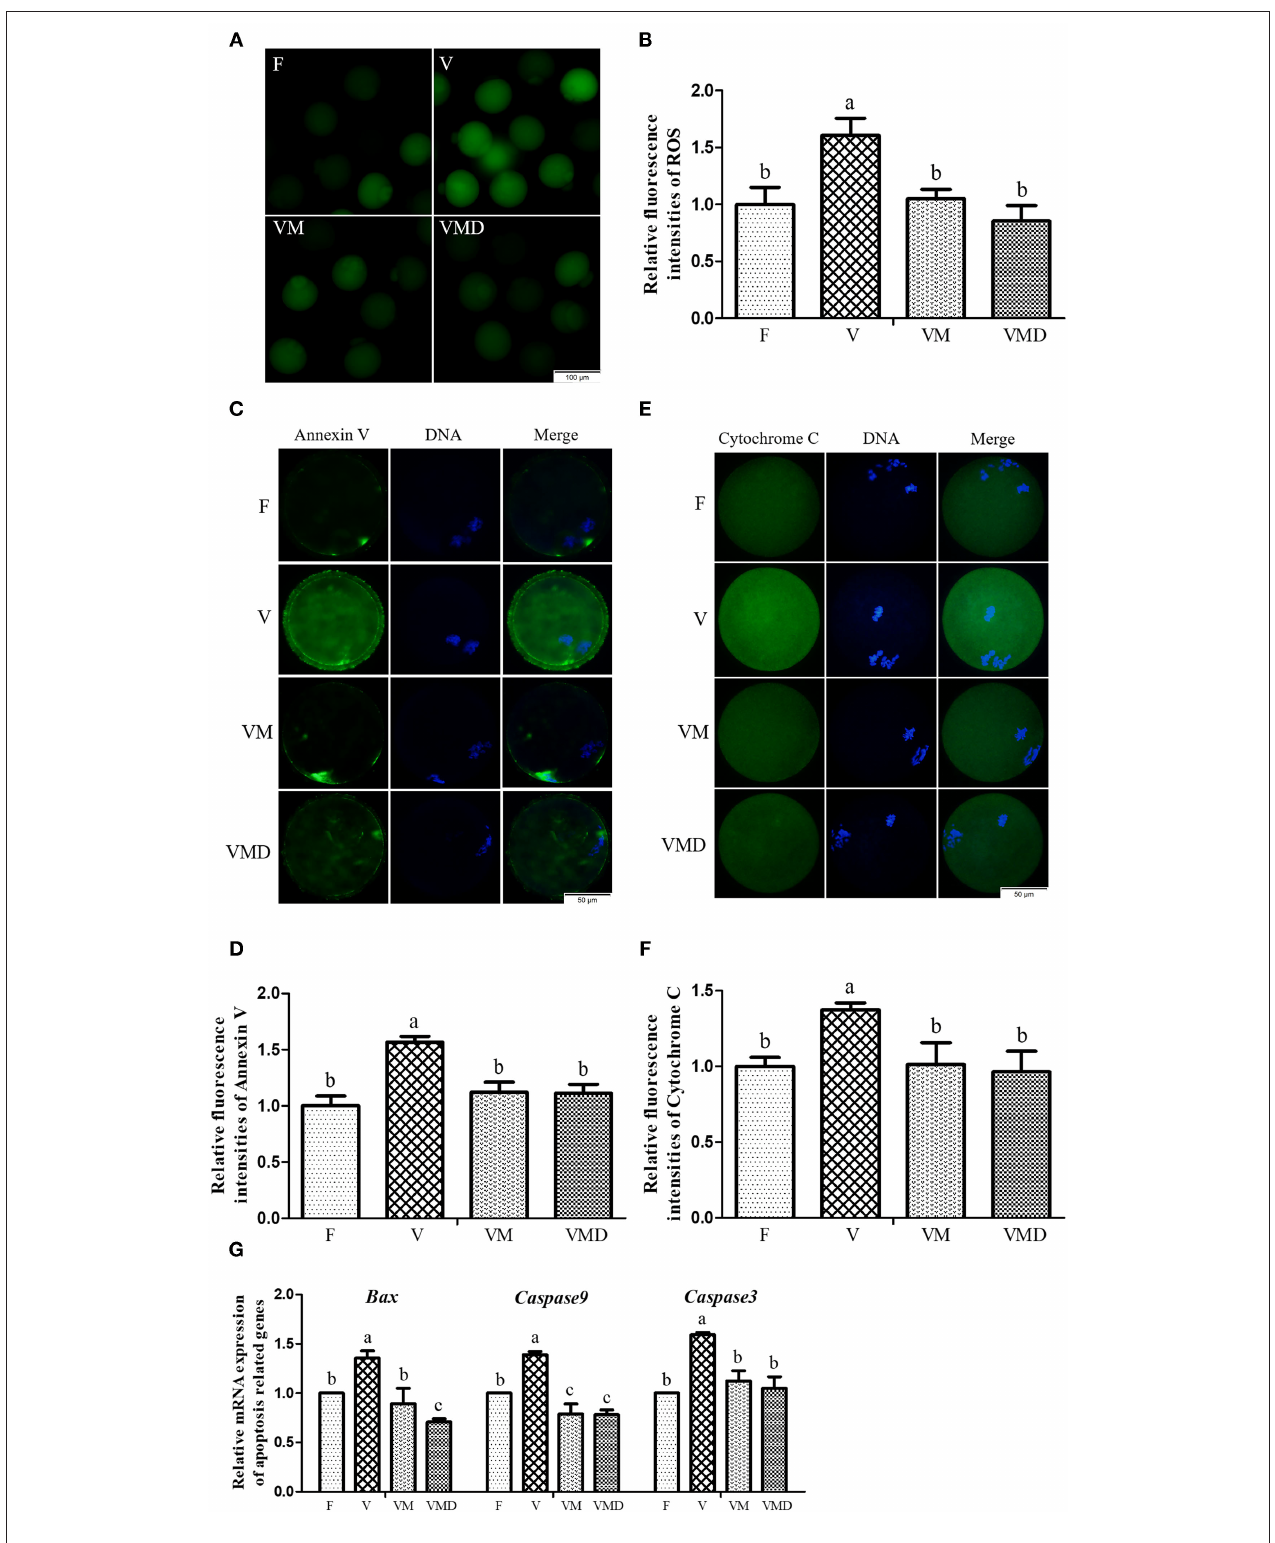
FIGURE 5 | Effects of melatonin on oxidative stress and apoptosis in MII oocytes derived from vitrified-warmed mouse GV oocytes. (A) Representative images of oocytes staining with DCHFDA. Scale bar, 100 µ m. (B) The fluorescence intensity of ROS levels was recorded using ImageJ software. In total, n = 150 MII oocytes were used in this assay (F: n = 32; V: n = 41; VM: n = 42; VMD: n = 35). (C) Representative images of oocytes staining with Annexin V. Scale bar, 50 µ m.